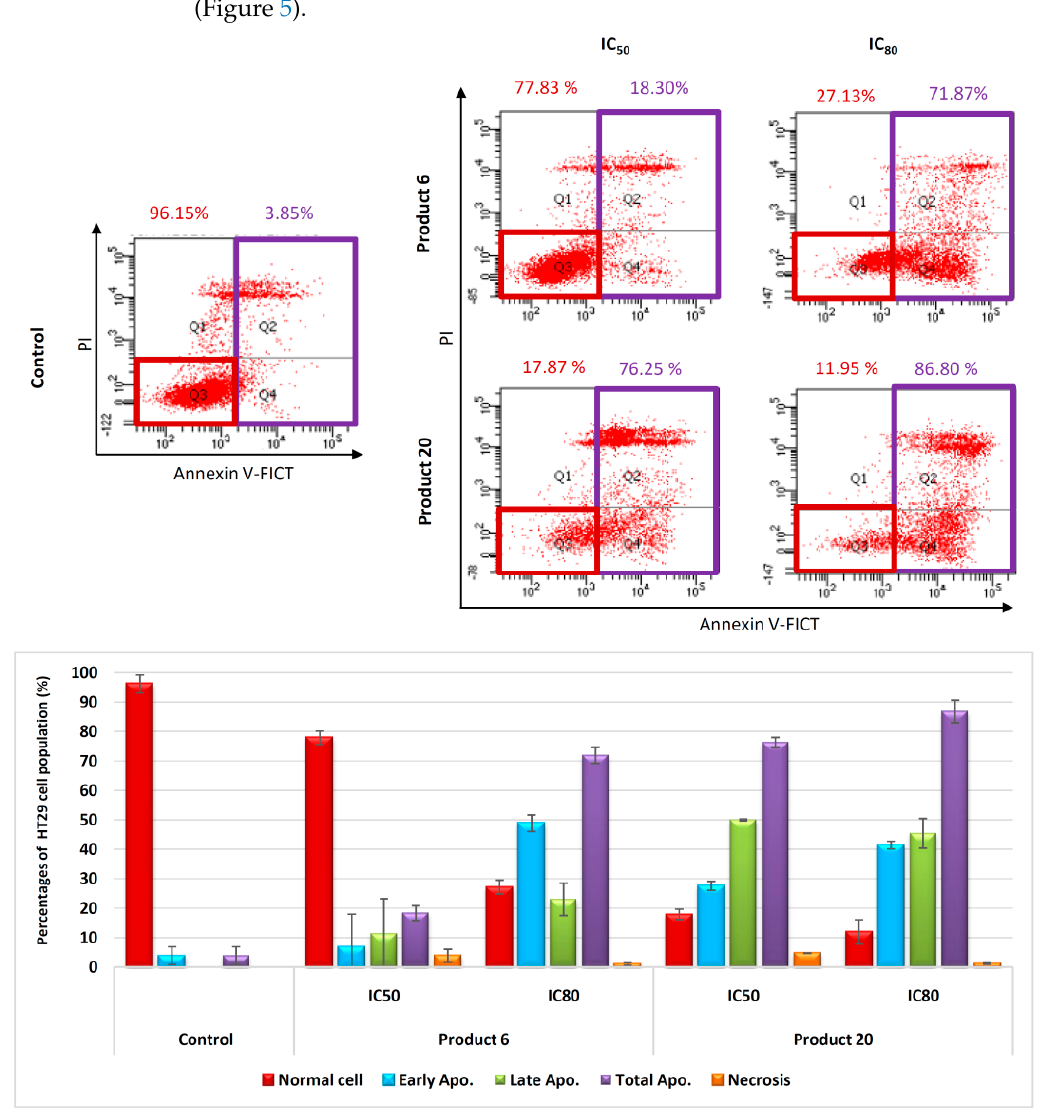
Figure 5. Flow cytometric analysis of Annexin V-FITC staining and propidium iodide (PI) accumulation after the exposure of HT29 cells to compounds 6 and 20 at IC 50 and IC 80 concentrations for 72 h. Top: Diagrams of annexin V/PI flow cytometry. The right quadrants of each diagram represent apoptotic cells (Q2, late apoptosis; Q4, early apoptosis). Bottom: Flow cytometry analysis of Annexin V-FITC staining and PI accumulation. Values represent the mean ± S.E.M of duplicate independent experiments, performed in